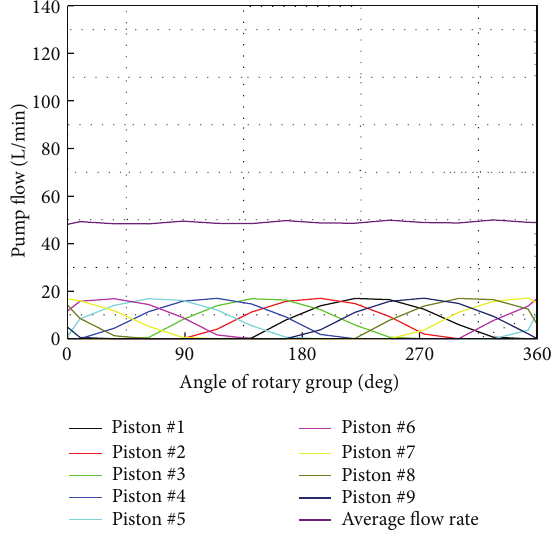
Figure 17: Simulation result of discharge flow ripple for variable displacement axial piston